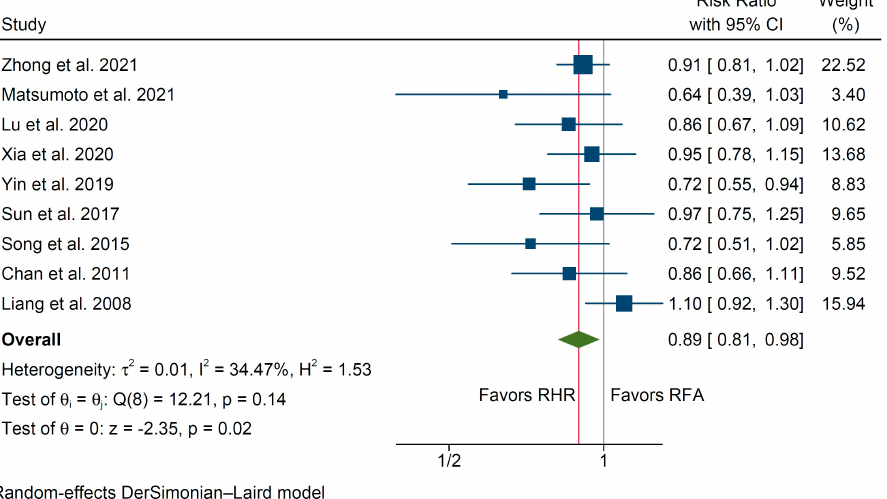
Figure 4. Forest plot of the odds for developing a second recurrence in patients undergoing repeat hepatic resection (RHR) versus radiofrequency ablation (RFA) of recurrent hepatocellular carci- noma [23,26,29 – 32,34,36,38].